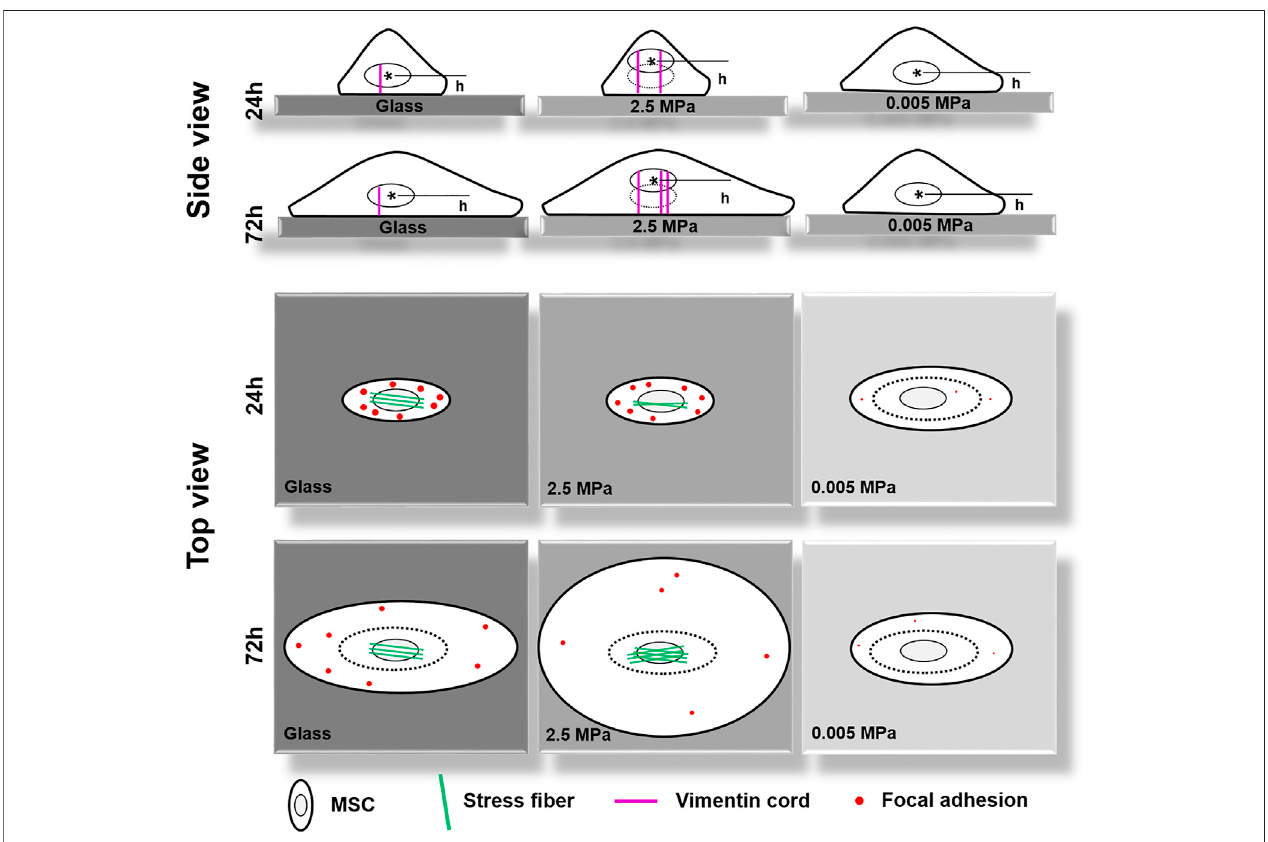
FIGURE 8 | A working model proposed for illustrating the coupled impacts of substrate stiffness and orientation on gravity-vector induced mechanical remodeling of rat bone marrow-derived stem cells. Here are two key points: (1) On stiff poly-dimethylsiloxane (PDMS), the orientation dependence of nuclear longitudinal translocation issimilar tothatonto glass via cytoskeletalremodelingand focaladhesion reorganization;(2)SoftPDMS tends toregulate cellmorphology,spreading,and focal adhesion formationwithout avisibleorientationdependence ofnuclear translocation. Thick cycle,cellmembrane; thincycle,nucleus (alsothin dotted cycle in the right panel); magentalines, vimentin cords; green lines, actin fi bers; red dots, large- or small-sized focal adhesions. h , thedistancefrom the nuclear centroid( * )tothe bottom surface of the